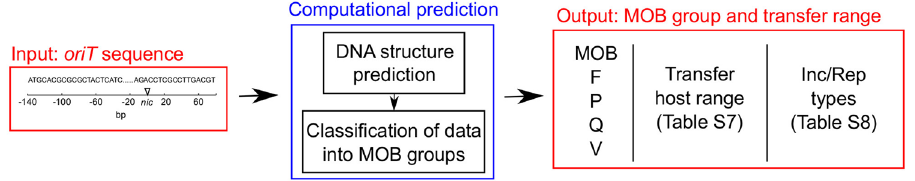
Figure 6. Overview of the oriT structure-based prediction procedure. Based on an input oriT sequence, the computational procedure predicts (i) the MOB group of the particular oriT and plasmid as well as (ii) the range of potential transfer hosts and Inc/Rep types (see Discussion). Two types of predictive classification models are available to the user, based the training sets of either 64 or 200